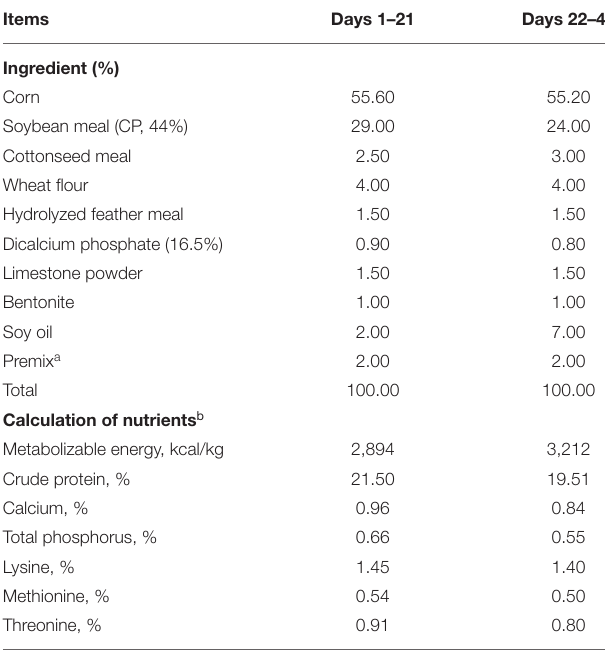
TABLE 1 | Composition and nutrient level of the basal